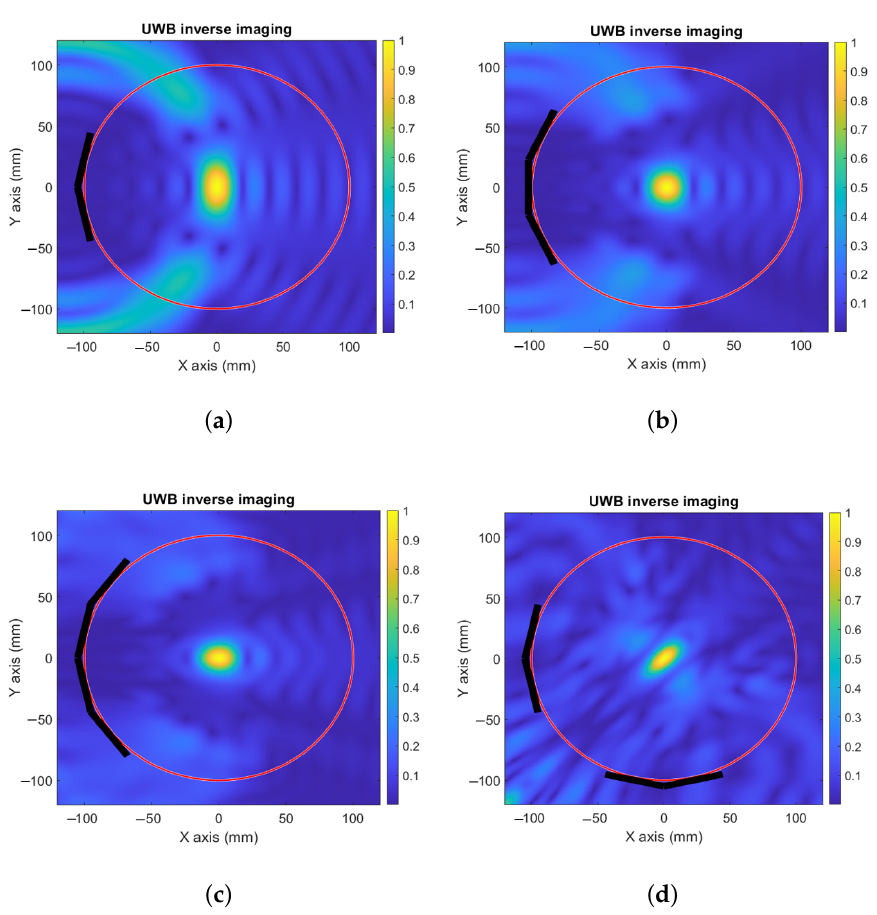
Figure 4. Analytical validation of the inverse imaging. ( a ) Two UWB antennas. ( b ) Three UWB antennas. ( c ) Four UWB antennas. ( d ) The orthogonal set of two